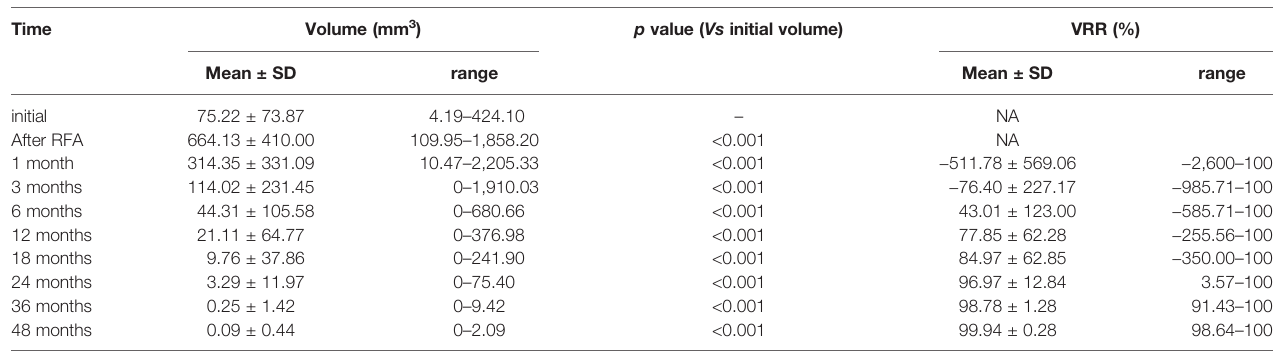
TABLE 2 | Changes of the volume and VRR after RFA at each